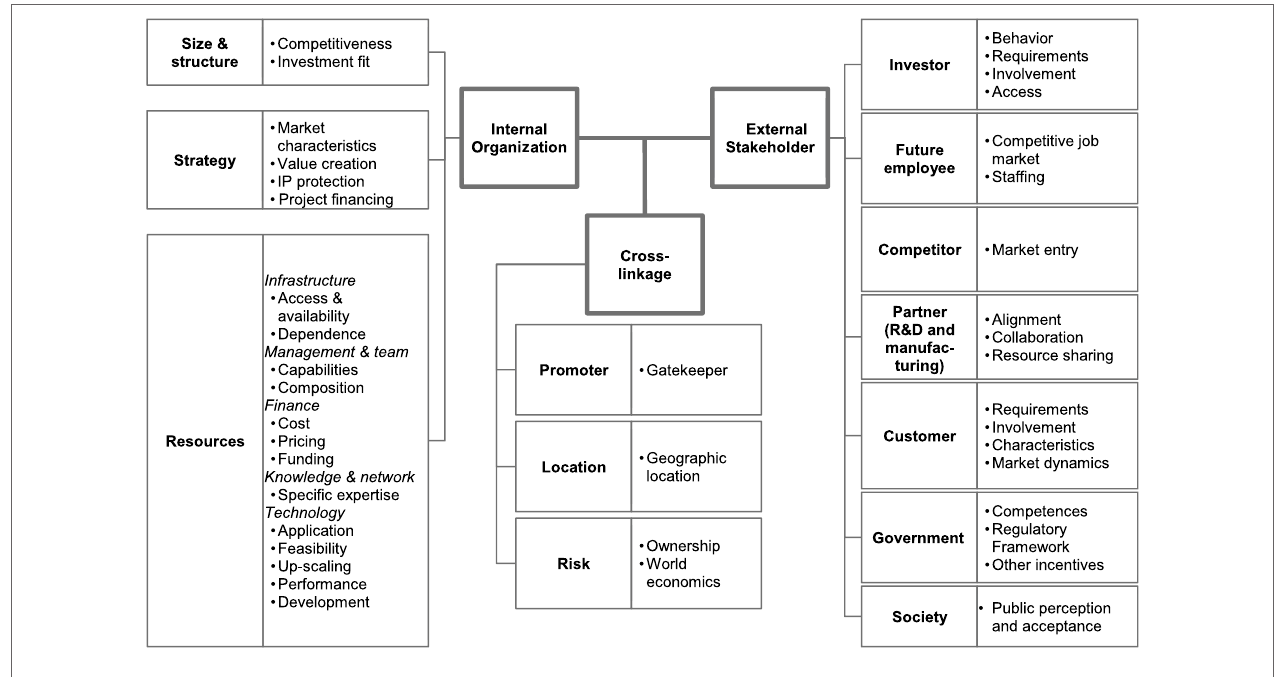
FigUre 3 | Multilevel barrier